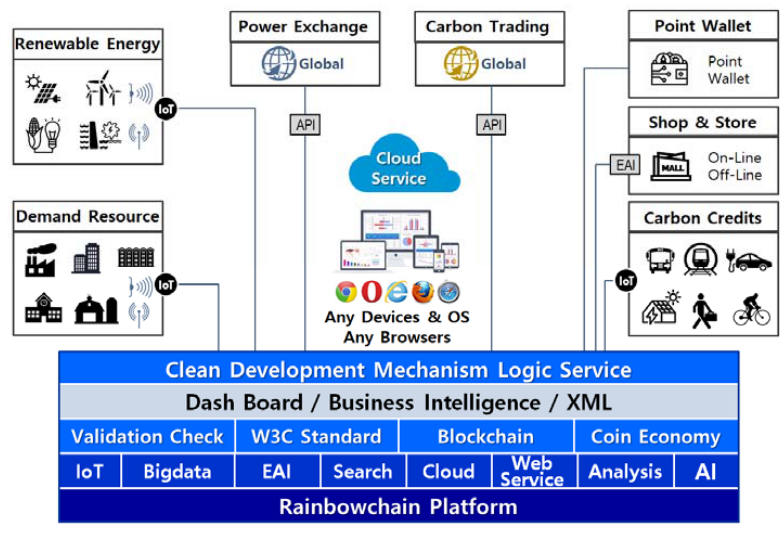
Figure 24. Rainbowchain platform.